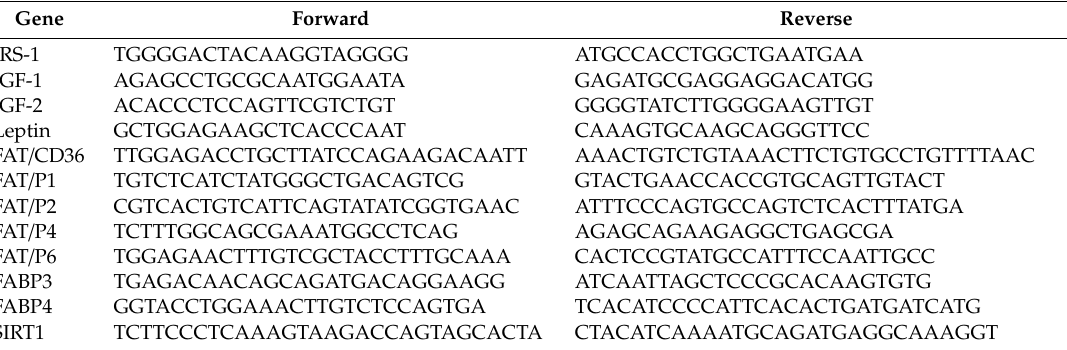
Table 1. Quantitative real-time PCR primer